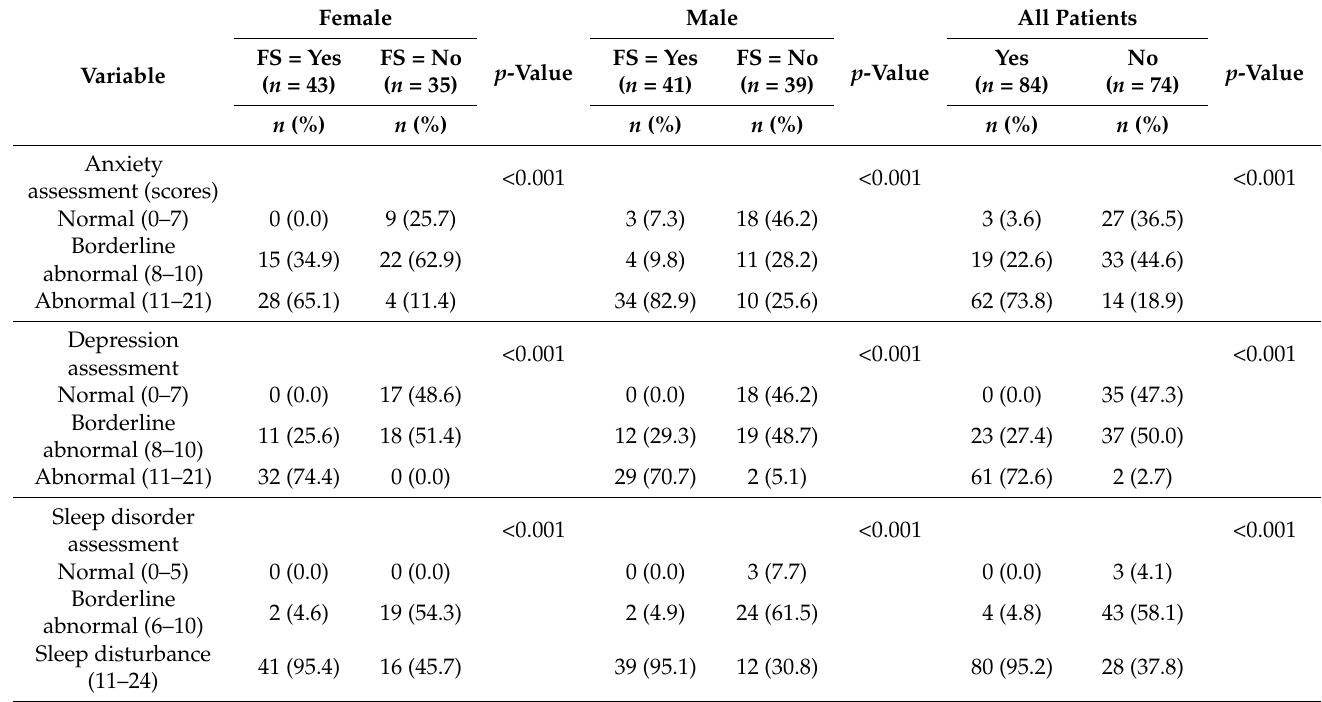
Table 4. Depression, anxiety and sleep disturbance in atrial fibrillation (AF) patients depending on gender and the presence of frailty syndrome (FS).